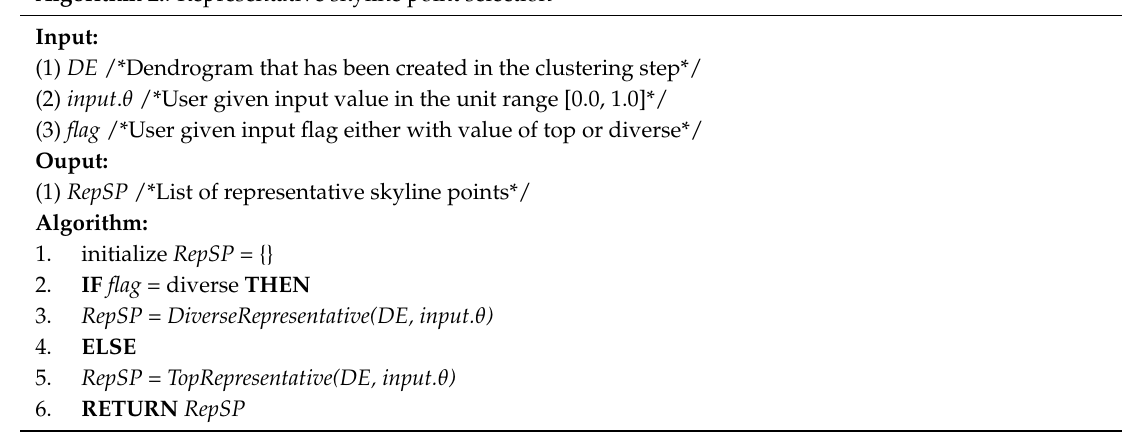
Algorithm 2. : Representative skyline point